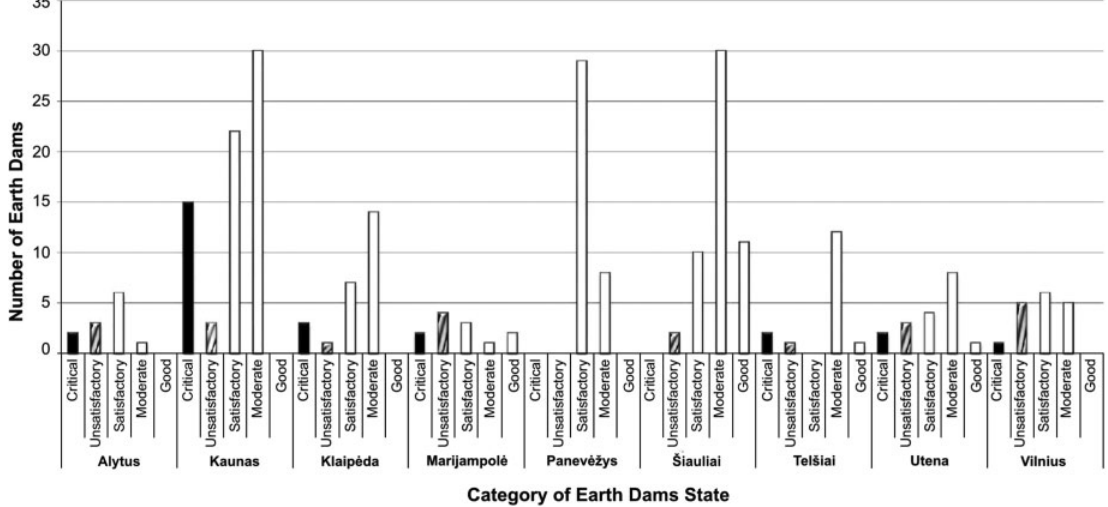
Fig. 2. Distribution of the technical state category of investigated dams in 2002–2009